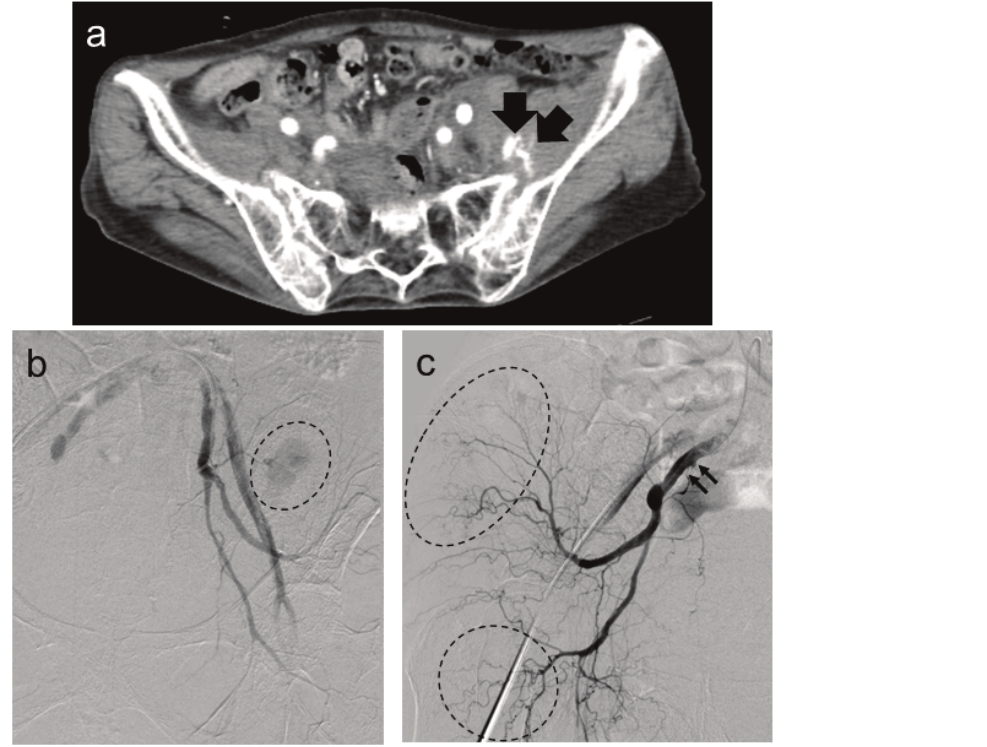
Figure 1: Enhanced CT shows extravasation from the left iliolumbar artery (a, arrows). Arteriography shows extravasation from the left iliolumbar artery (b, circle with dotted line), irregularity of the right internal iliac artery (c, arrows), and provides suspicion of extravasation from the superior and inferior gluteal arteries (c, circle with dotted